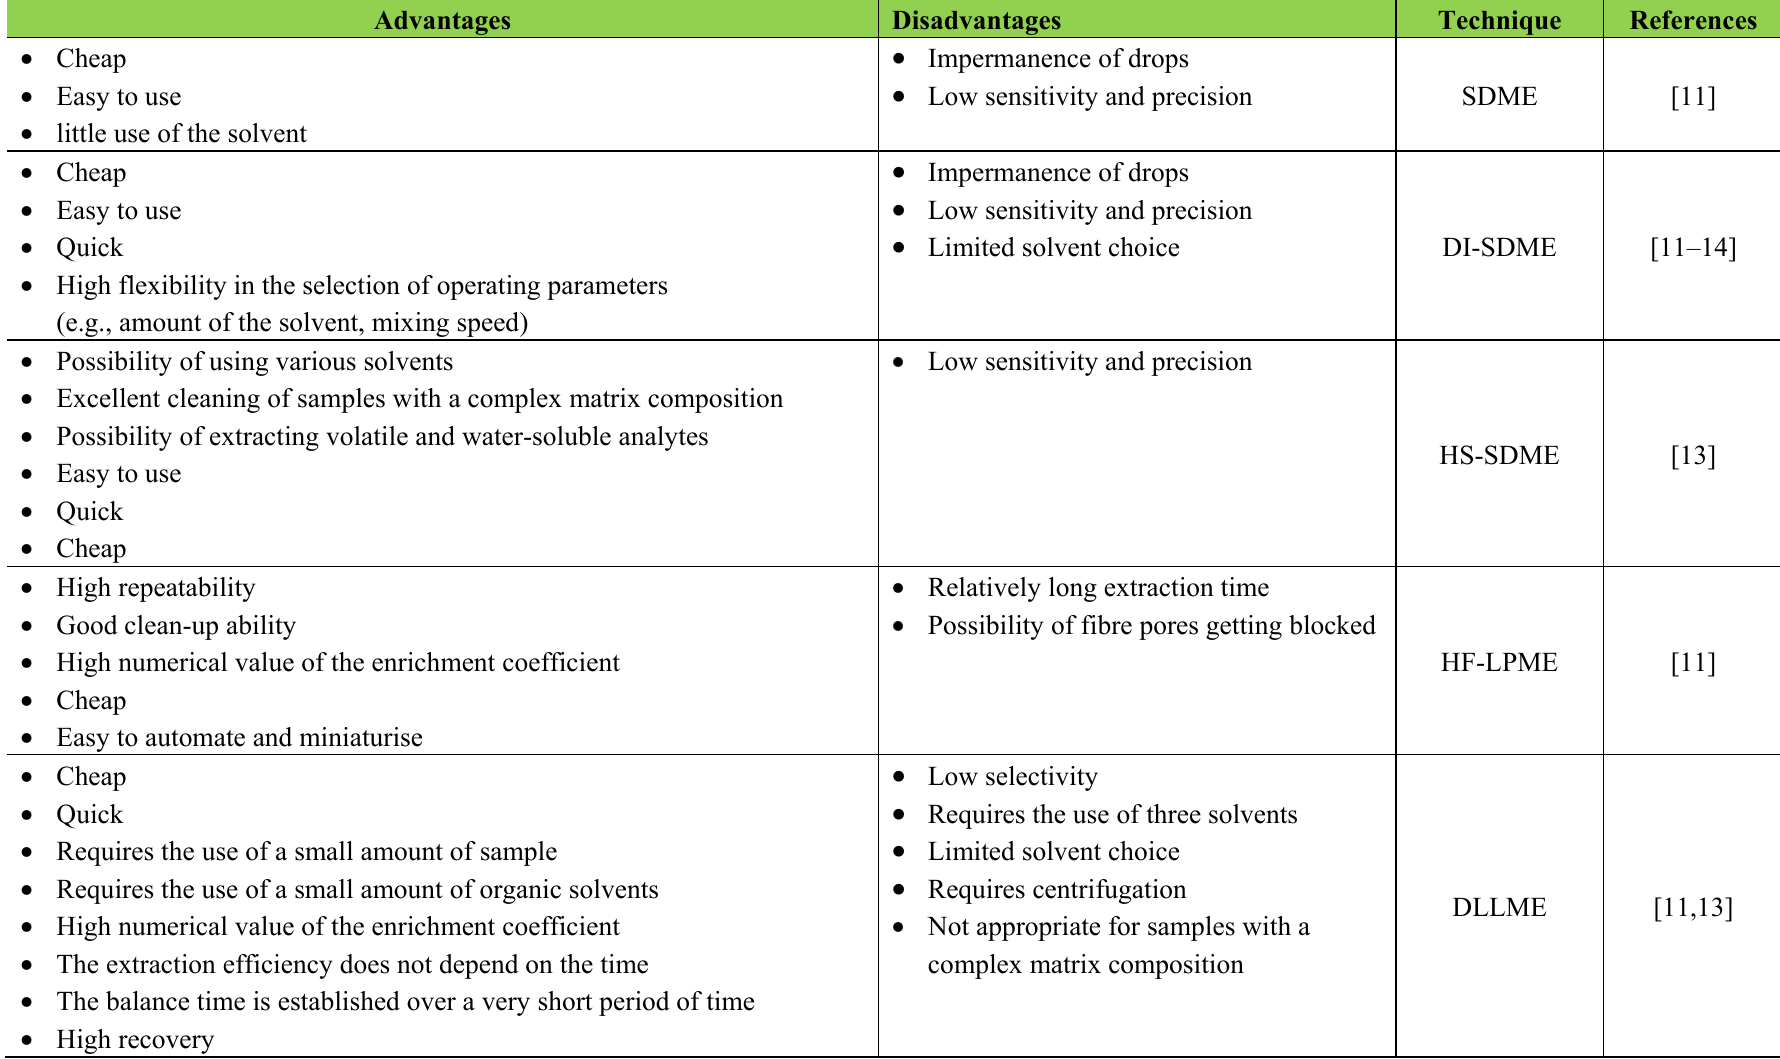
Table 5. Advantages and disadvantages of selected microextraction